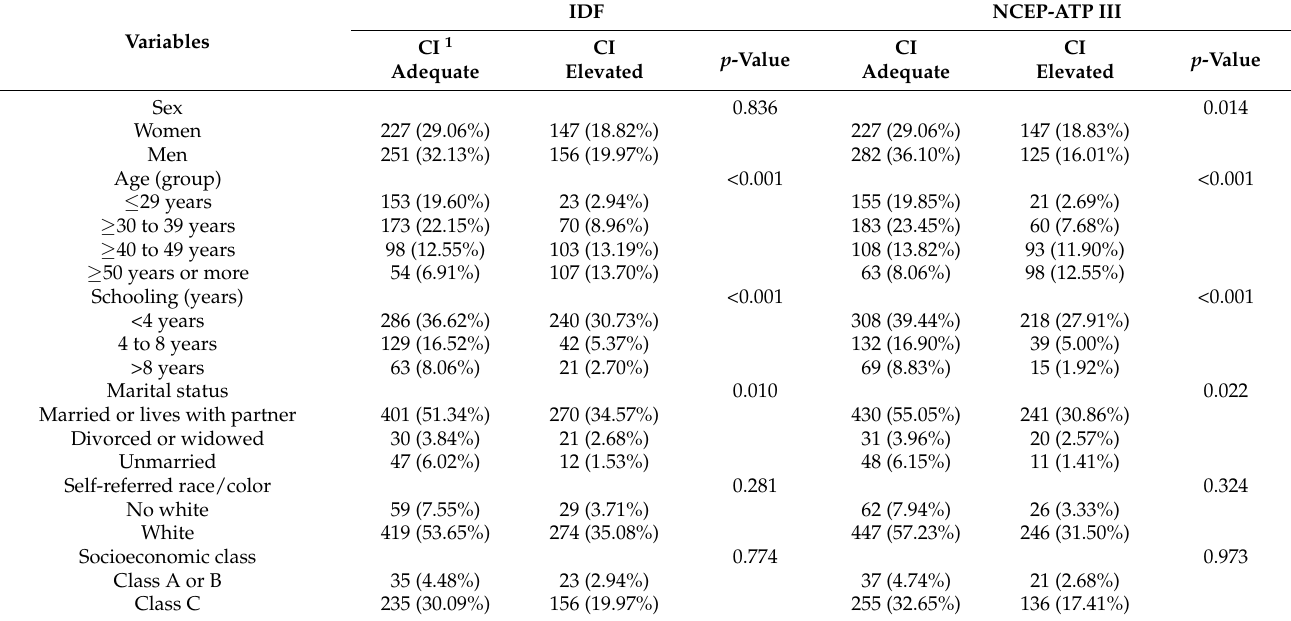
Table 2. Sociodemographic, food consumption and occupational factors of rural